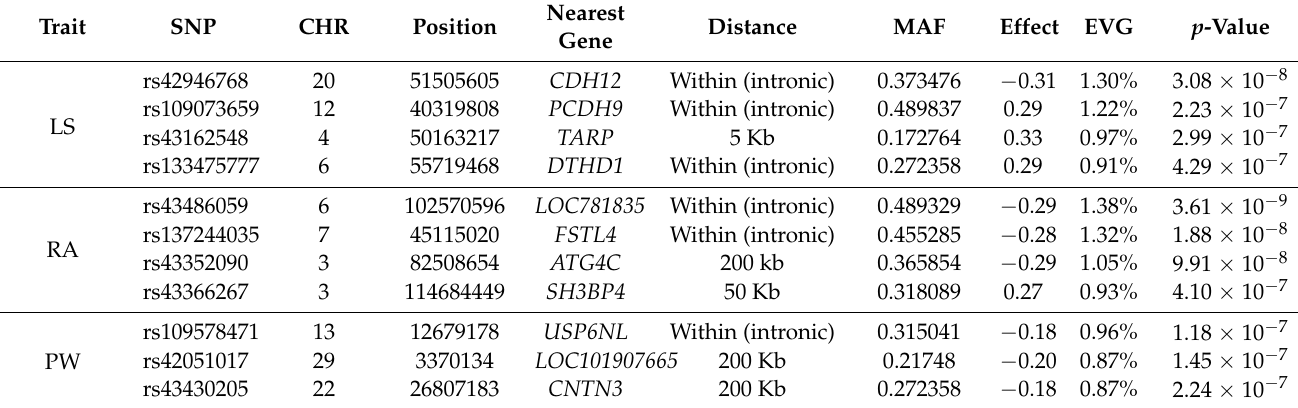
Table 2. Information relating to the identified significant single-nucleotide polymorphisms (SNPs) and the nearest genes. Trait